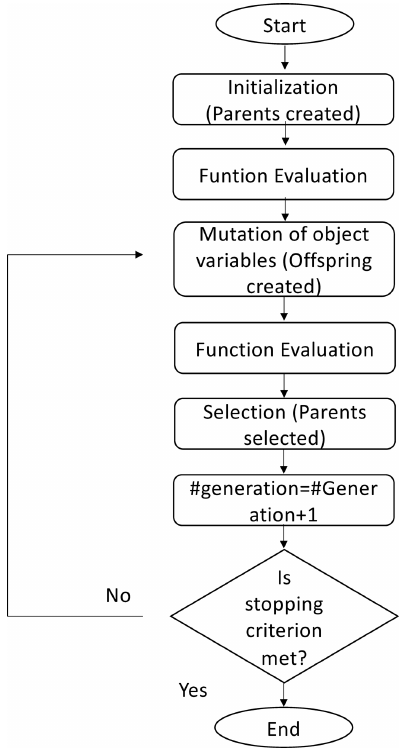
Figure 6. Flowchart of the evolution